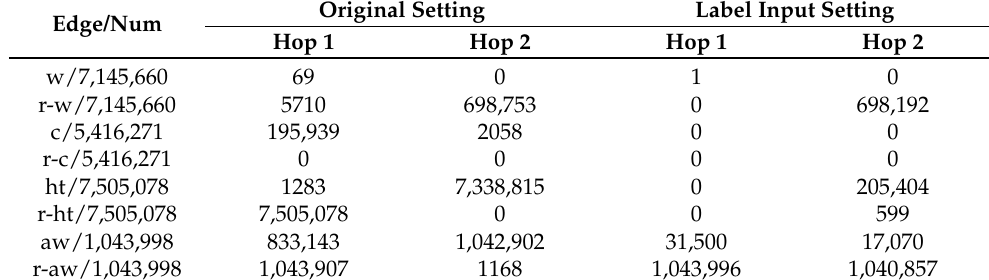
Table 8. Statistics of numbers of edges that HGPN learns to purify under 2 two training settings. “w” means “writes”, “c” means “cites”, “ht” means “has topic”, “aw” means “affiliated with”. “r-x” means the reverse type of edge type “x”. “Hop i” denotes neighbours from i -th hop.